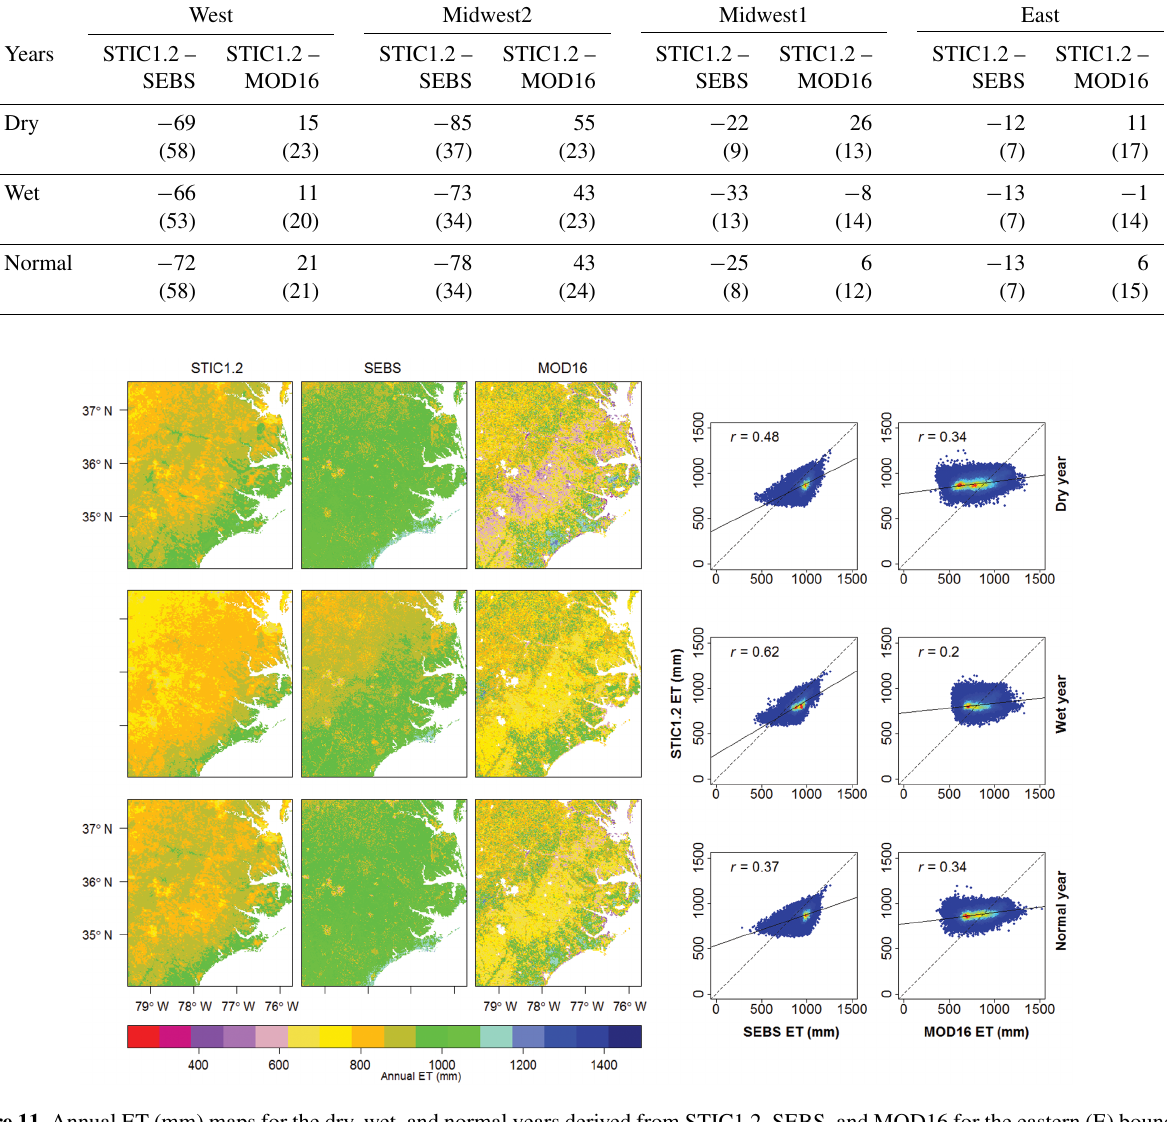
Figure 11. Annual ET (mm) maps for the dry, wet, and normal years derived from STIC1.2, SEBS, and MOD16 for the eastern (E) bounding box covering US-NC1 and US-NC2 flux sites (Fig. 1). Scatter plots between annual ET estimates from STIC1.2 vs. SEBS and MOD16 are shown on the